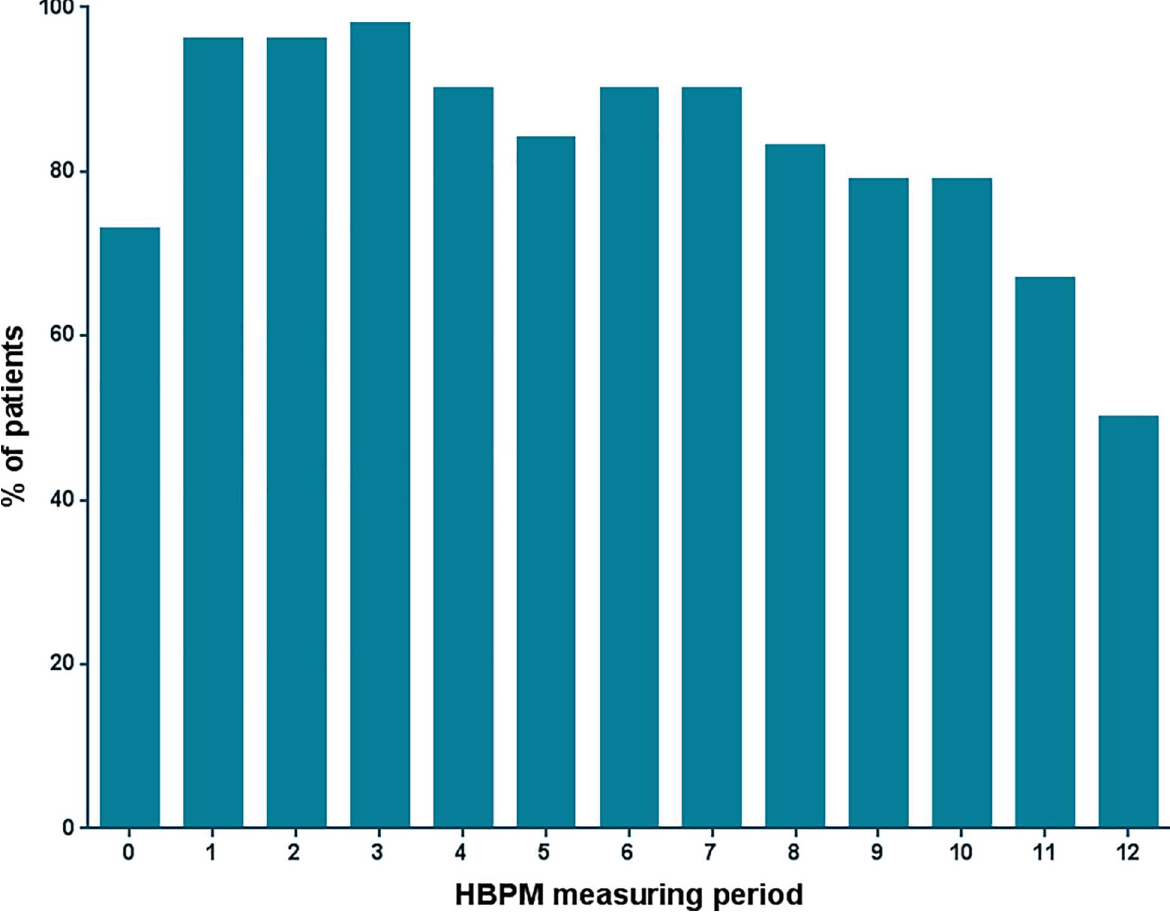
Fig 1. Amount of measurements contributingto HBPM. Figuredepicts the percentageof patientscompleting homeblood pressure measurements (HBPM)for each measuringperiod.